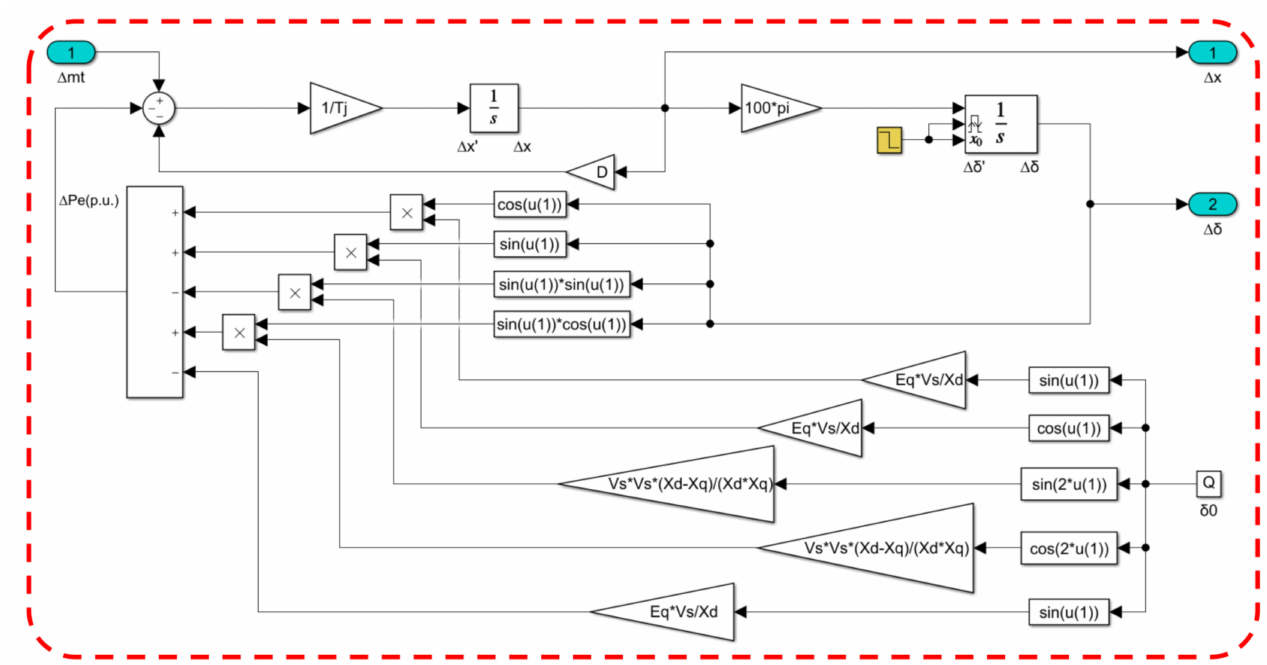
Figure 9. Simulation model of